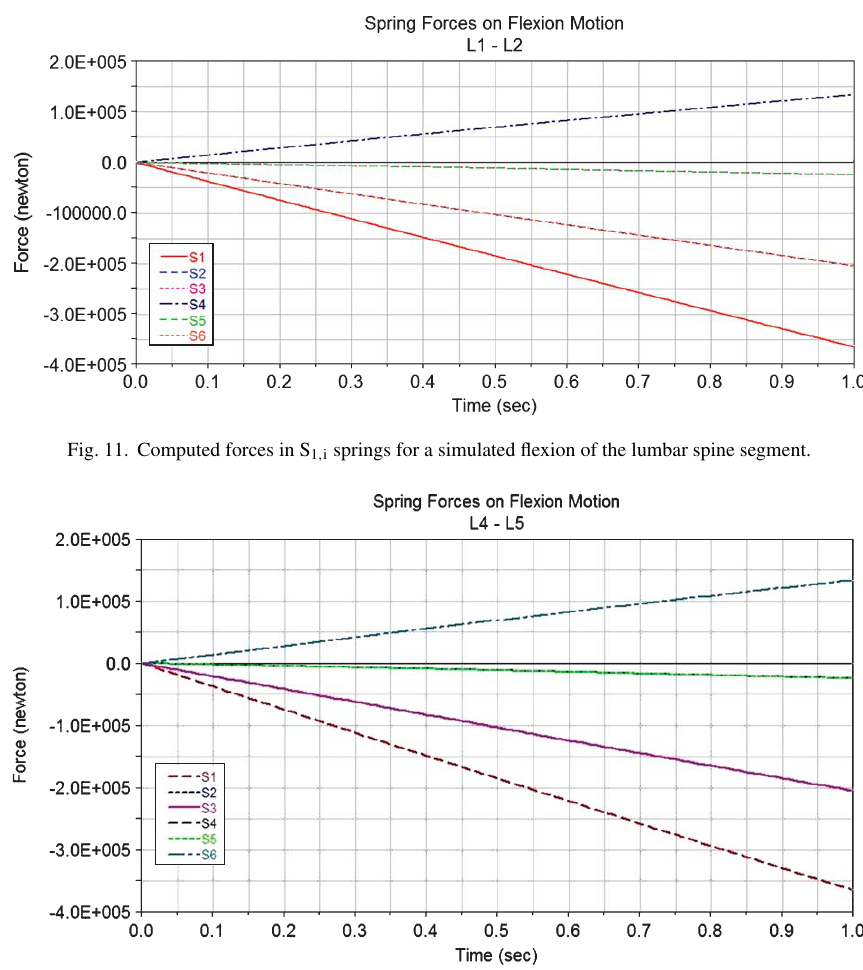
Fig. 12. Computed forces in S 4 , i springs for a simulated flexion of the lumbar spine